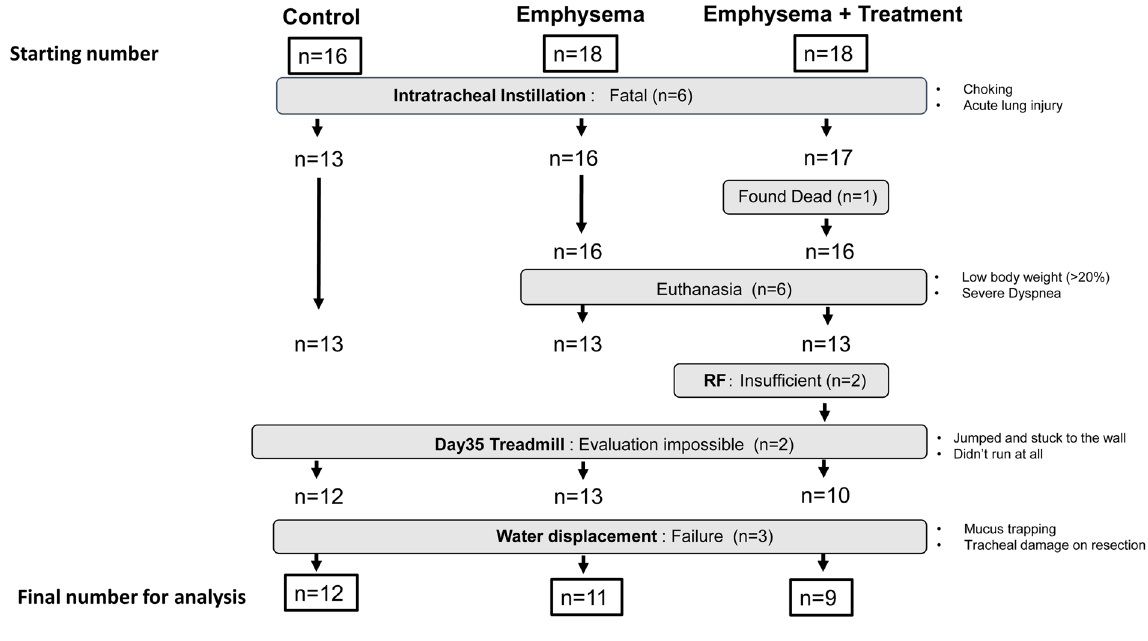
Figure 3. The flow of the